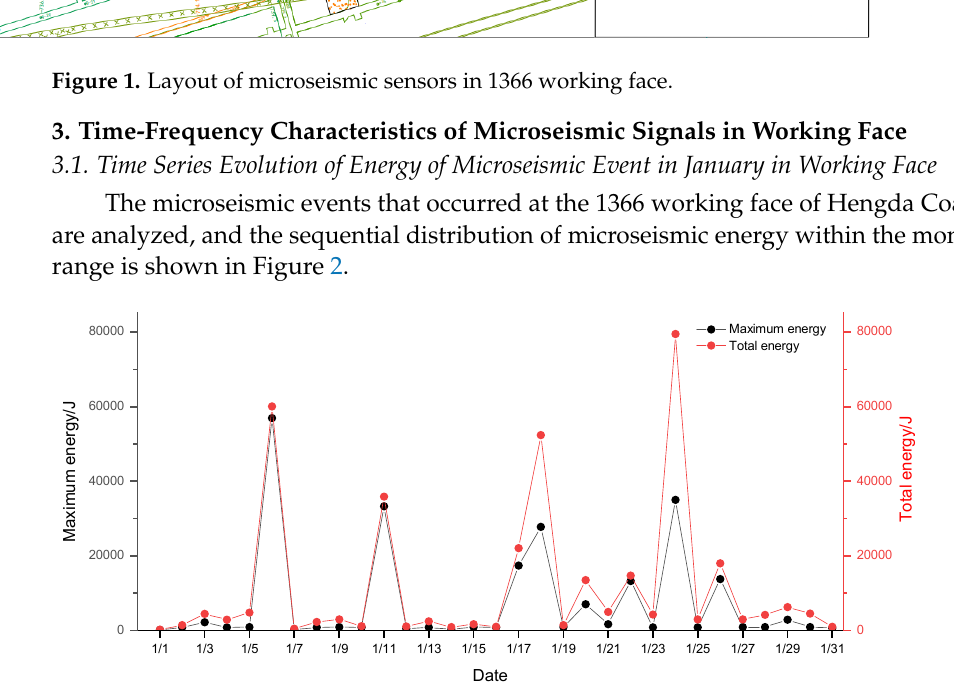
Figure 2. Sequential evolution of microseismic energy in January at 1366 working face of Hengda Coal Mine.